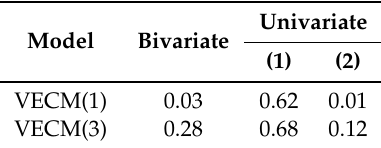
Table 5. p -values of Doornick–Hansen normality